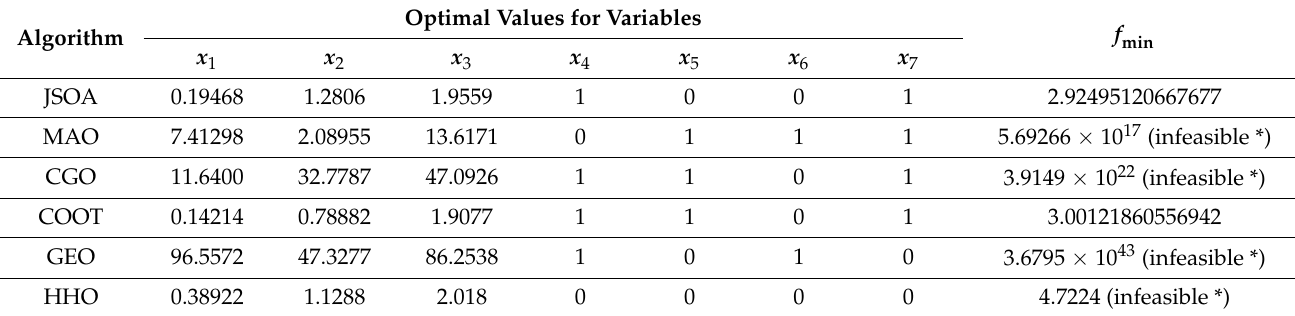
Table 7. Comparison results for the Process Synthesis